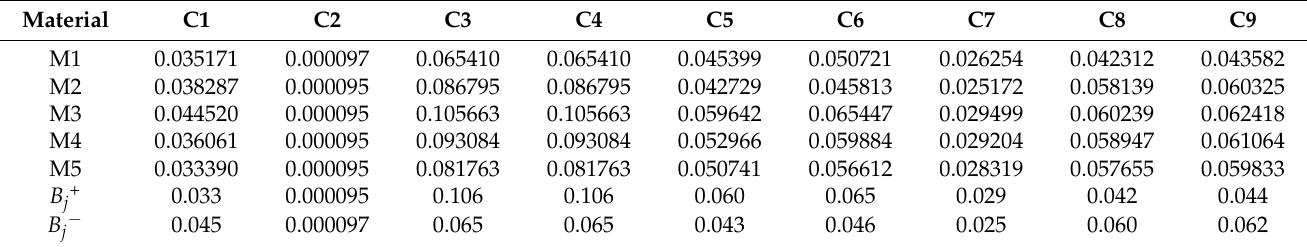
Table 12. TOPSIS normalized weighted matrix.